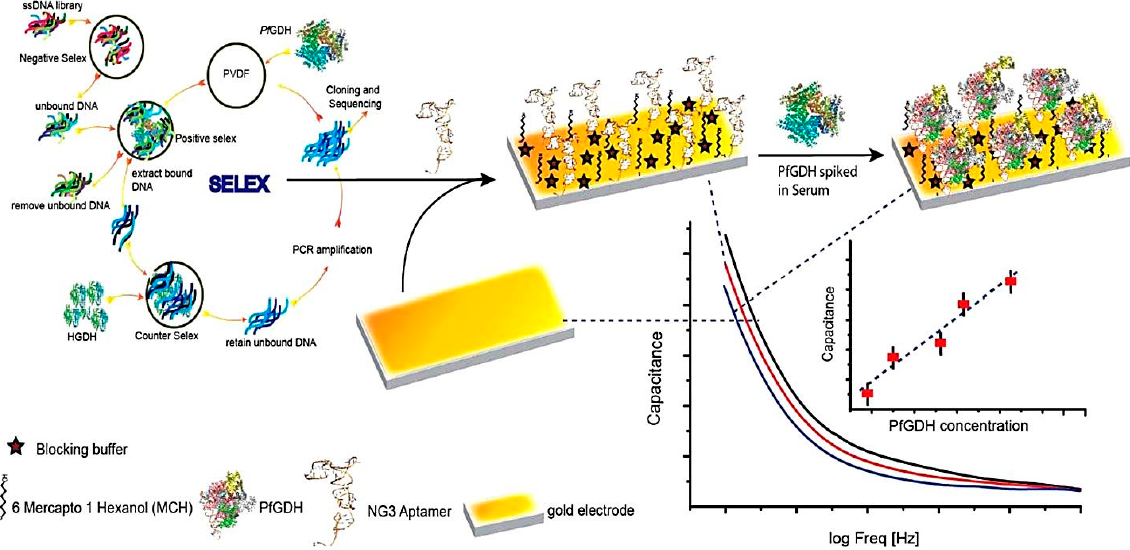
Figure 7. Schematic illustration of apatamer selection and the fabrication steps of a label-free electrochemical aptasensor for the detection of Pf GDH. Reprinted from [52] with permission.